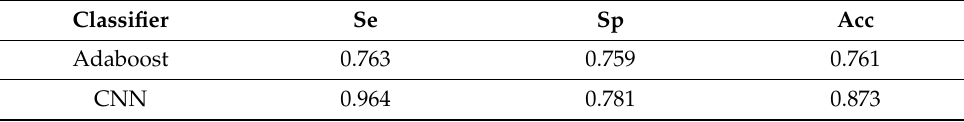
Table 7. Classification results under different